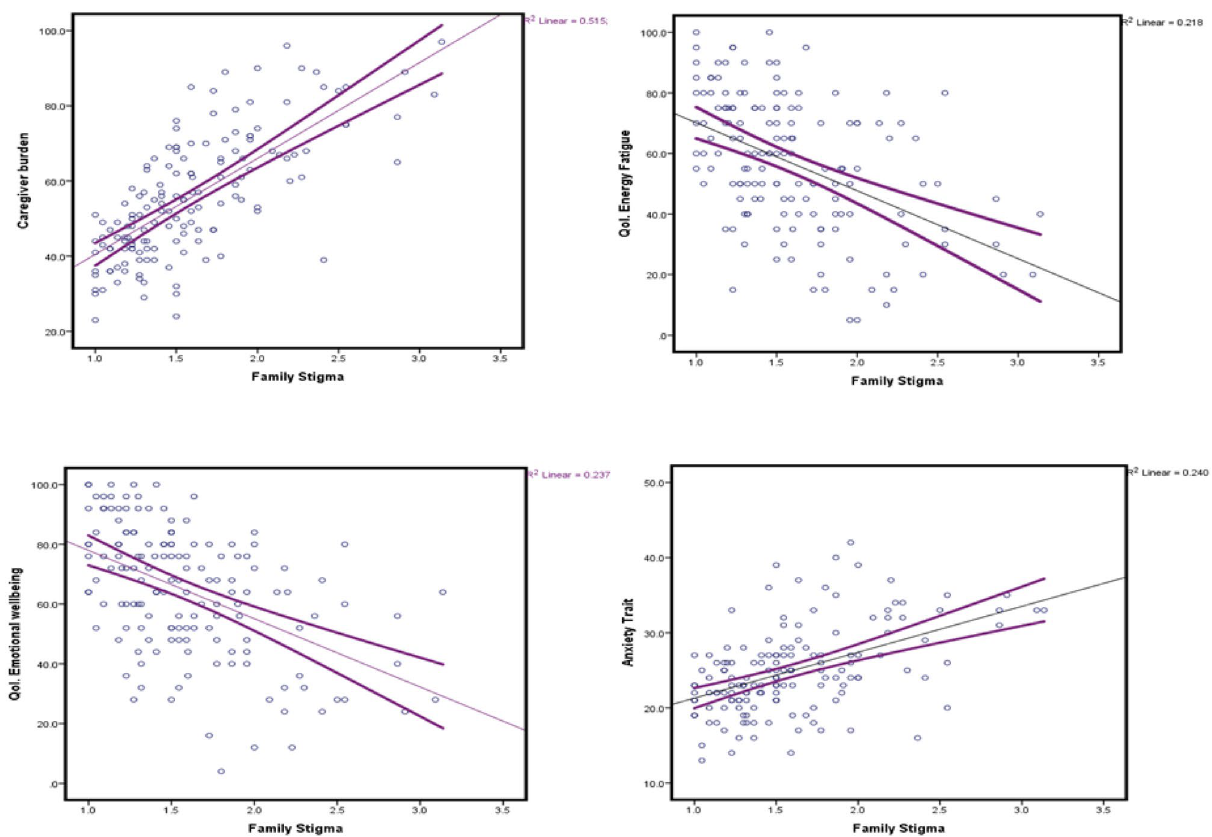
Figure 1. Negative psychological outcomes among caregivers according to family